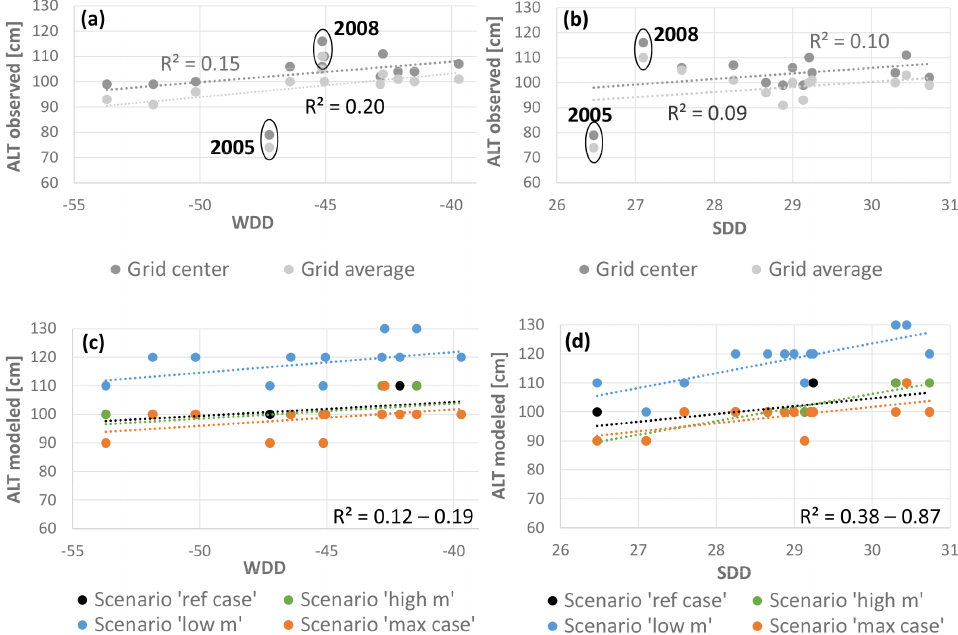
Figure 6. (a, b) Correlation of observed and (c, d) modelled active layer thicknesses to thermal conditions at the ground surface, considering winter degree days (WDD) and summer degree days (SDD) separately. Observed active layer measurements include information both from the grid centre (dark grey) and the grid average (light grey). Modelled active layer thickness is shown for selected scenarios “ref case” (black), “low m ” (blue), “high m ” (green), and “max case” only (orange).